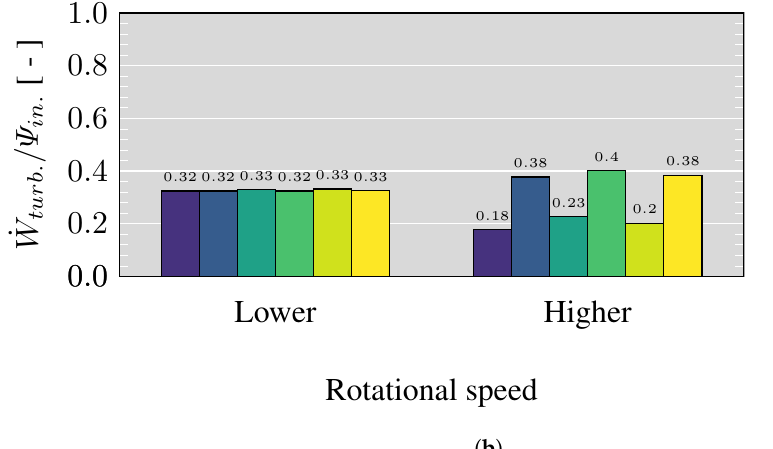
Figure 14. Exergy analysis for the evaluated operational points; lower: 3882 rpm/ √ K ; higher: 7456 rpm/ √ K . ( a ) Distribution of the normalized overall exergy in the turbine domain. ( b ) Compari- son of the turbine power with respect to the exergy at the inlet probe